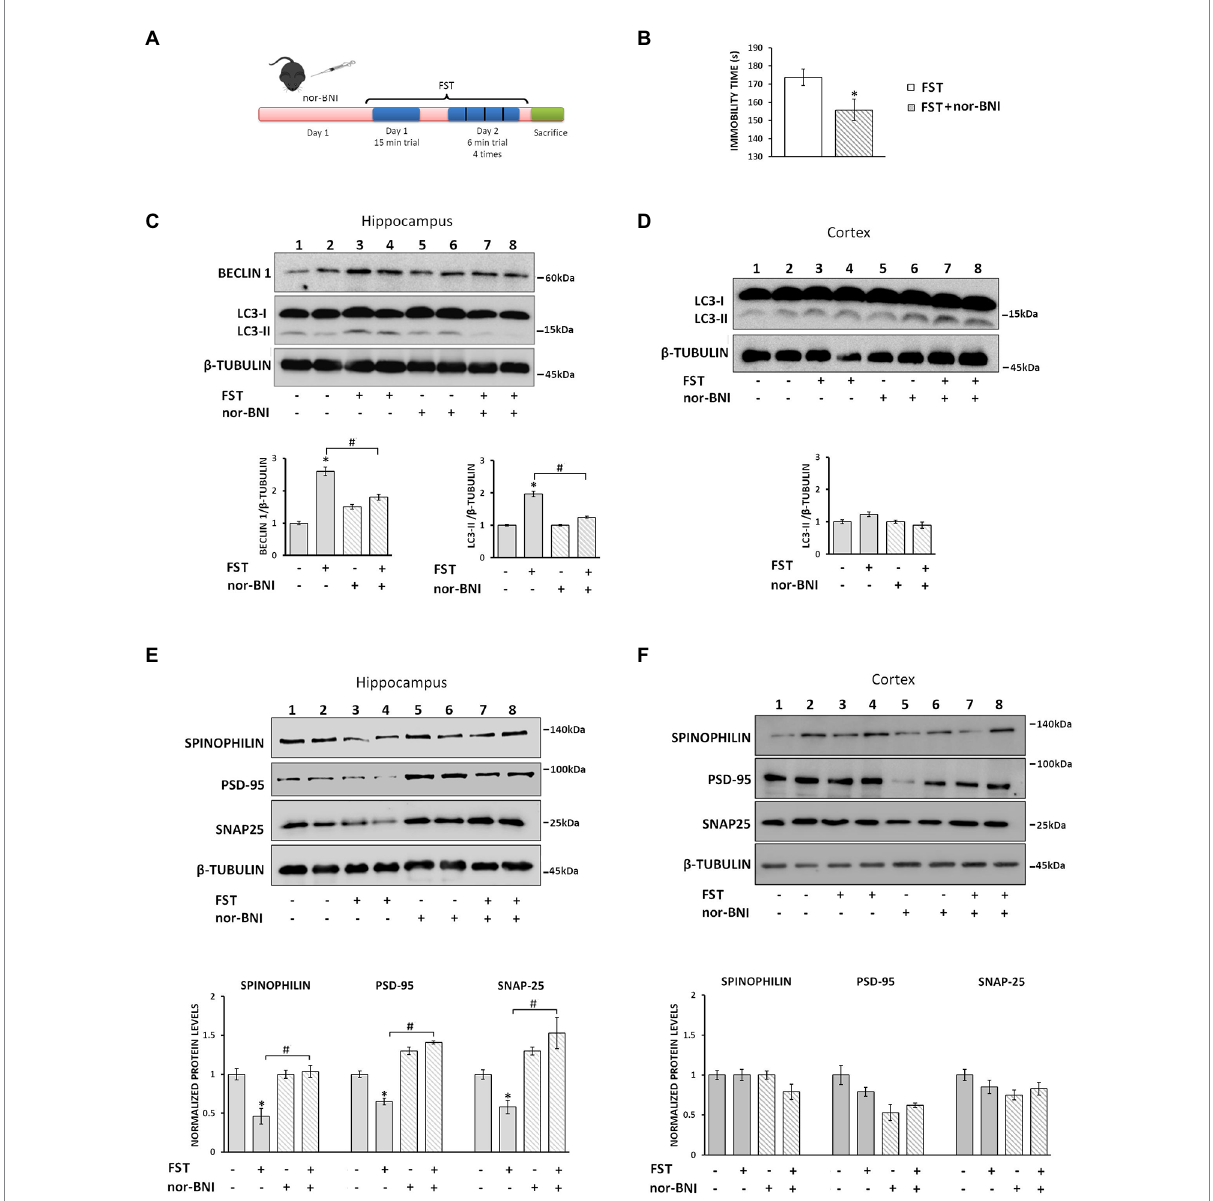
FIGURE 7 Nor-BNI blocks FST-induced autophagy promoting synaptic alterations in mouse hippocampus. (A) Experimental timeline of the nor-BNI administration protocol and the 2-day repeated FST in C57BL/6 J mice. Four groups of animals [saline and nor-BNI (non-stressed groups), and saline and nor-BNI exposed to FST (stressed groups)], ( n = 6/group) were injected i.p. with saline or the specific κ -OR antagonist nor-BNI (10 mg/kg) on day 1. One hour after injection, mice were subjected to 15 min FST. On the second day, mice were subjected to 4×6 min FST trials and immediately sacrificed and hippocampi and cortices were isolated. (B) For behavioral analysis the immobility time of mice was quantified using a video tracking software as described in Materials and Methods. Statistical analysis was performed by one-way ANOVA variance, *p < 0.05 relative to FST saline group. For autophagy induction, LC3-II and Beclin 1 levels were measured in hippocampus (C) and cortex (D) by Western immunoblotting. (E) The levels of spinophilin, PSD-95 and SNAP25 in the hippocampus were detected from the four groups to evaluate differences between the stressed and non-stressed animals injected with saline or nor-BNI. β -tubulin was used as the loading control. (F) Spinophilin, PSD-95 and SNAP25 levels were detected from isolated cortical lysates (50 μ g) from the four mice groups. The ratio of proteins to β -tubulin was normalized to control (saline non-stressed), which is set as 1. All data are presented as average ± SEM ( n = 6/group, * p < 0.05 as compared with the saline non-stressed group and # p < 0.05 compared with the saline stressed ones using two-way ANOVA with post-hoc